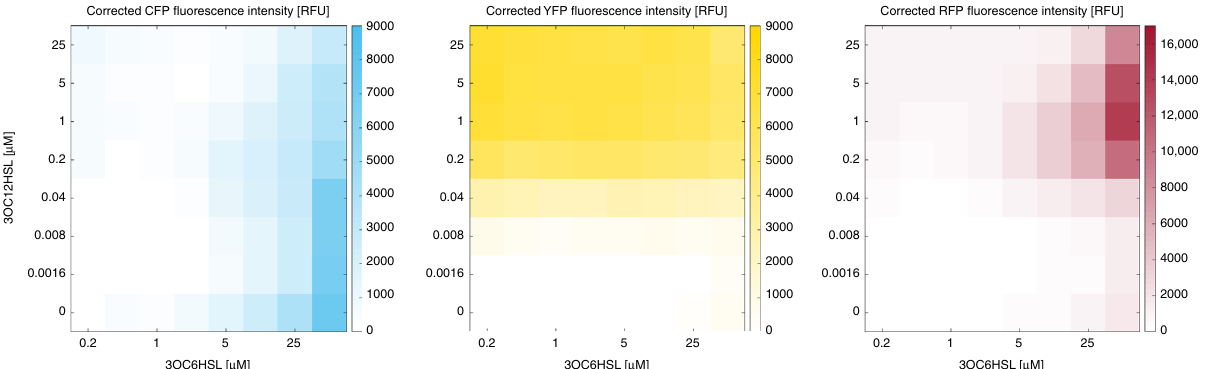
Fig. 4 An improved synthetic three-color circuit implementing AND gate-like behavior. The behavior of the high-dynamic-range bicistronic controller plasmid pCRB DRT7VTPLux*250 was tested alongside the RFP reporter plasmid p4g3R under a two-dimensional titration of 3OC6HSL and 3OC12HSL using a plate fl uorometer-based assay (see Methods for details). Fluorescence intensity, corrected for background signal present in the absence of externally supplied HSLs, is reported for each condition. Plots show average values from three biological replicate experiments performed on different days. Corresponding s.d. values are shown alongside individual induction curves in Supplementary Figure 8